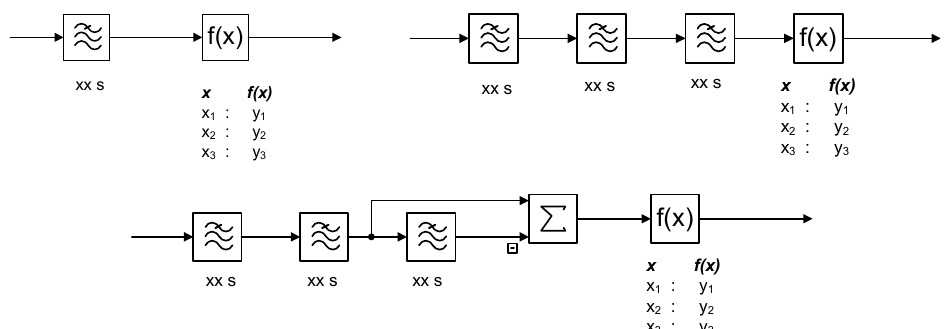
Figure 1. Noise filter industrial design